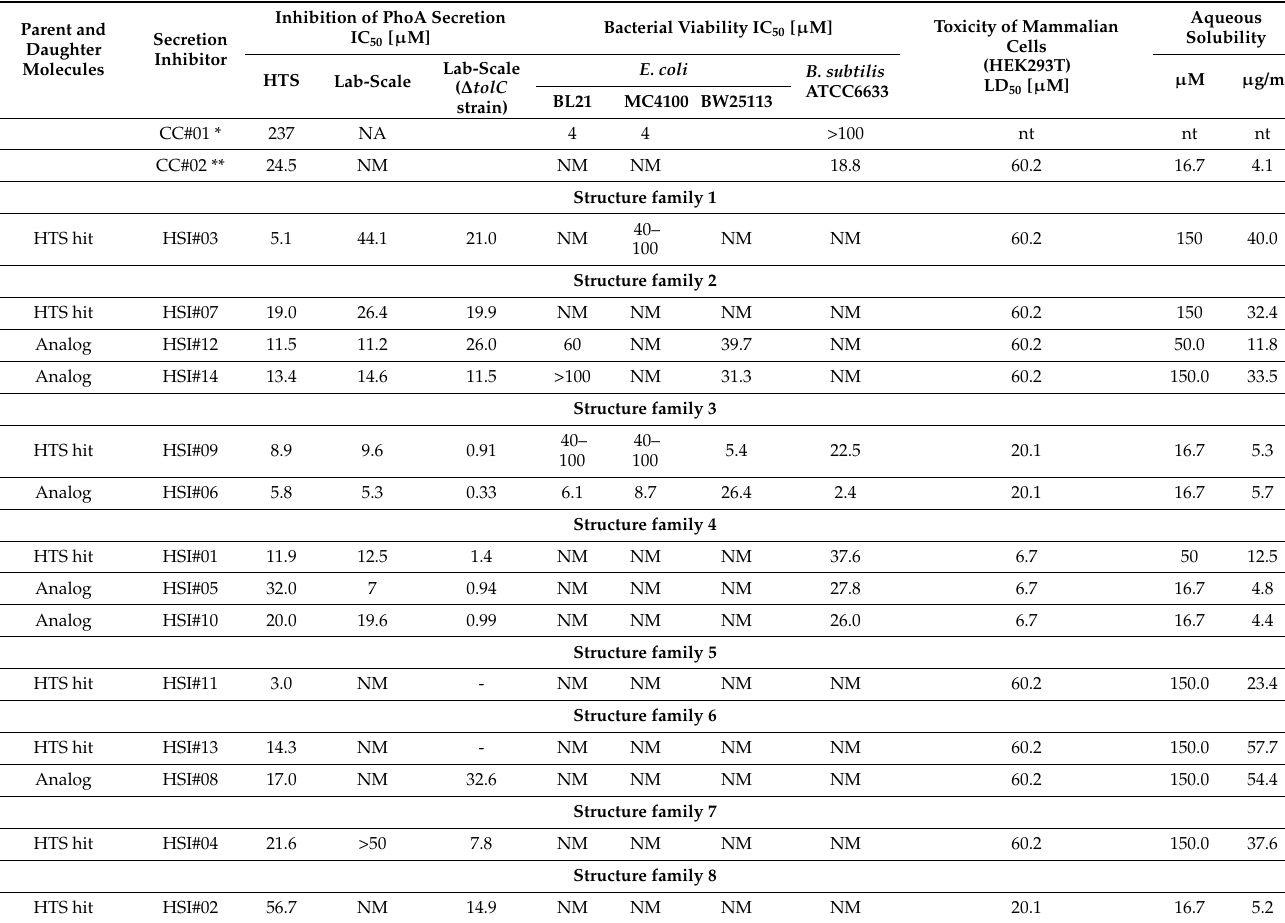
Table 1. Properties of PhoA secretion inhibitors returned from the